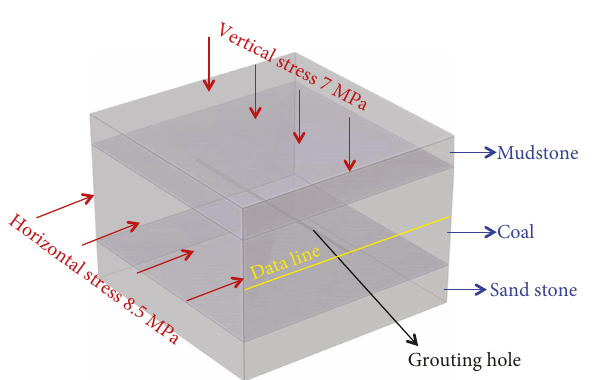
Figure 12: Calculation